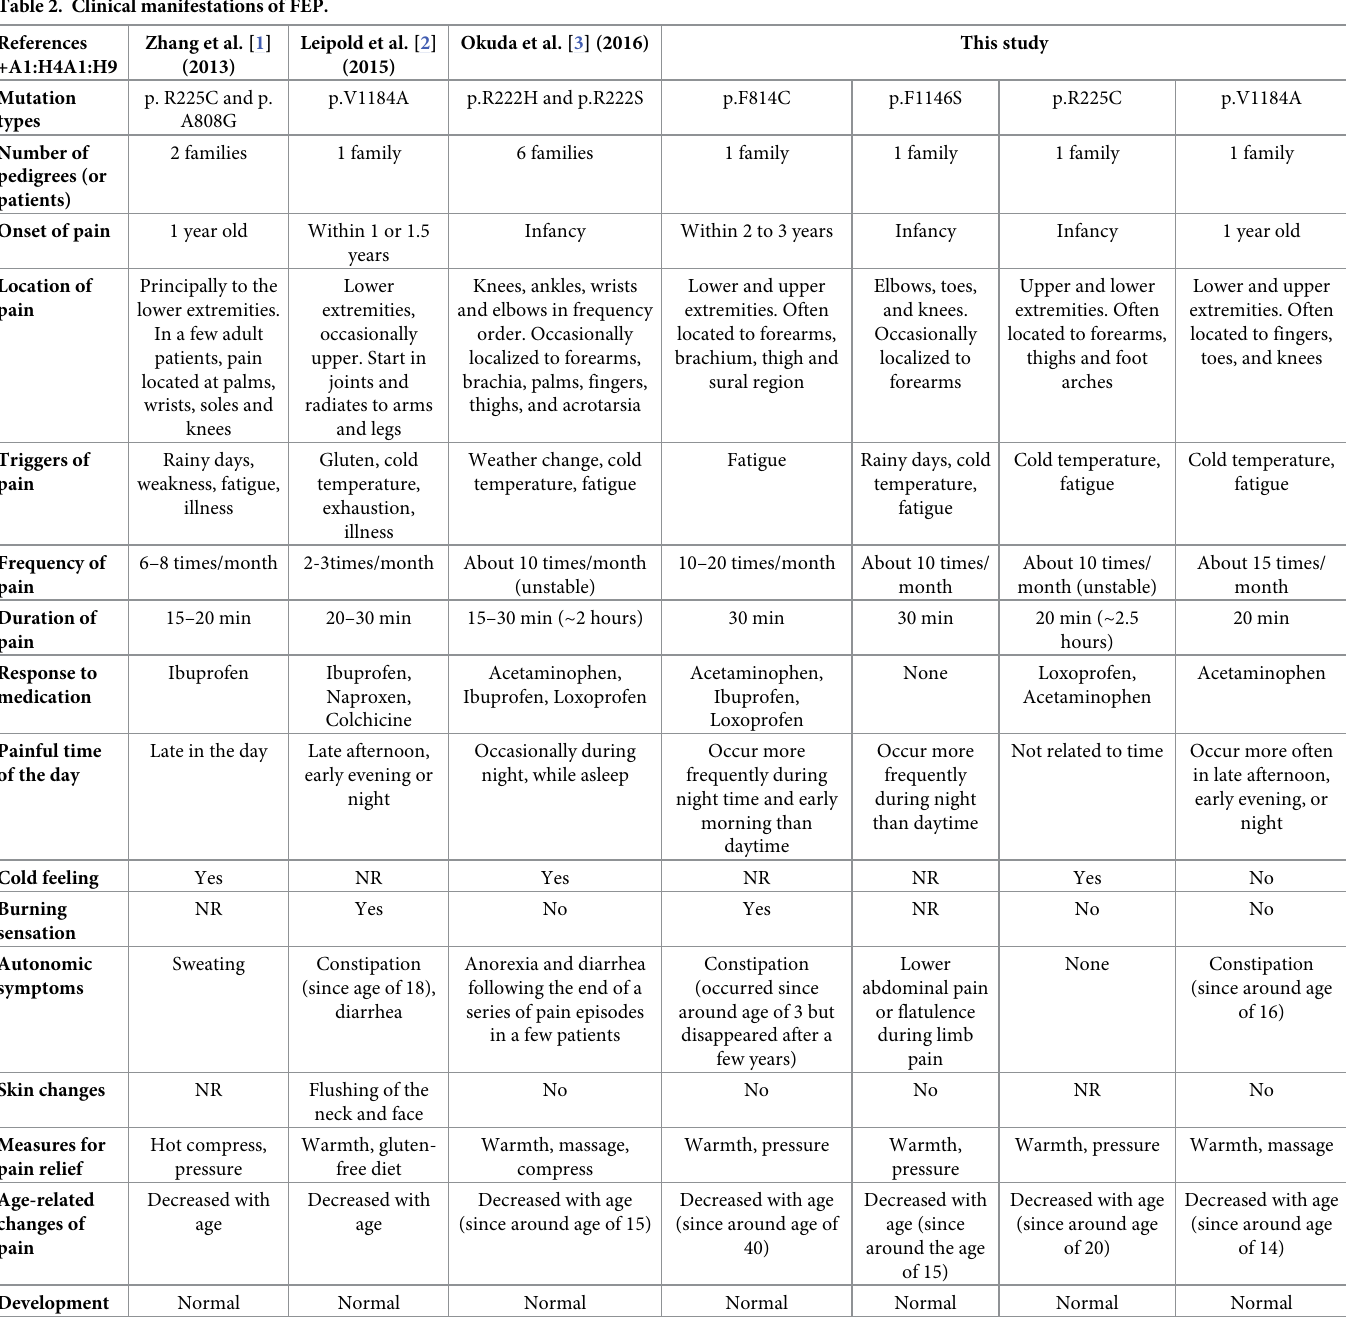
Table 2. Clinical manifestations of